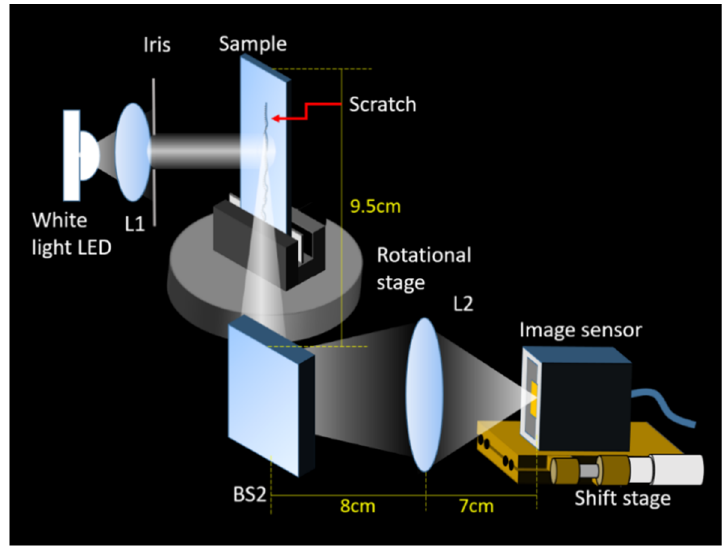
Figure 2. Schematic diagram of the WIS setup, where BS means beam splitter, and L means lens.